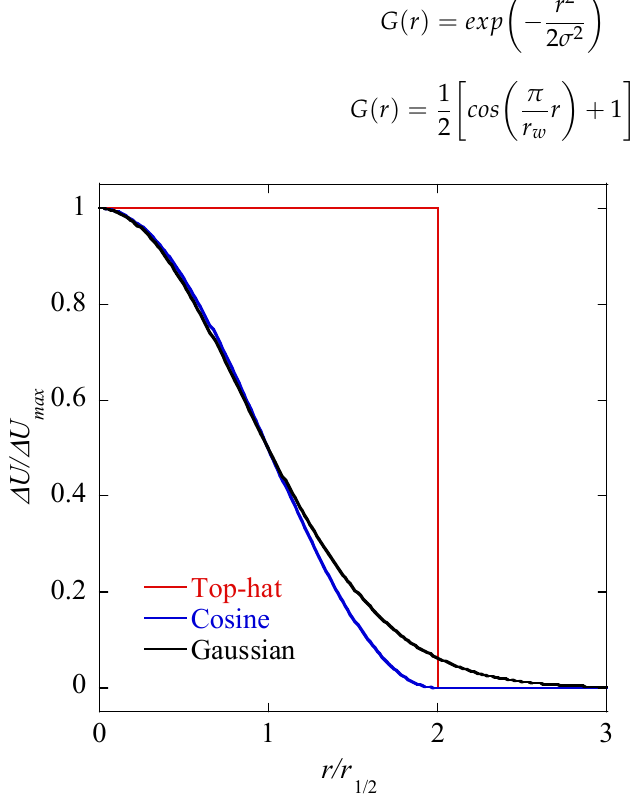
Figure 1. Spanwise distribution of velocity